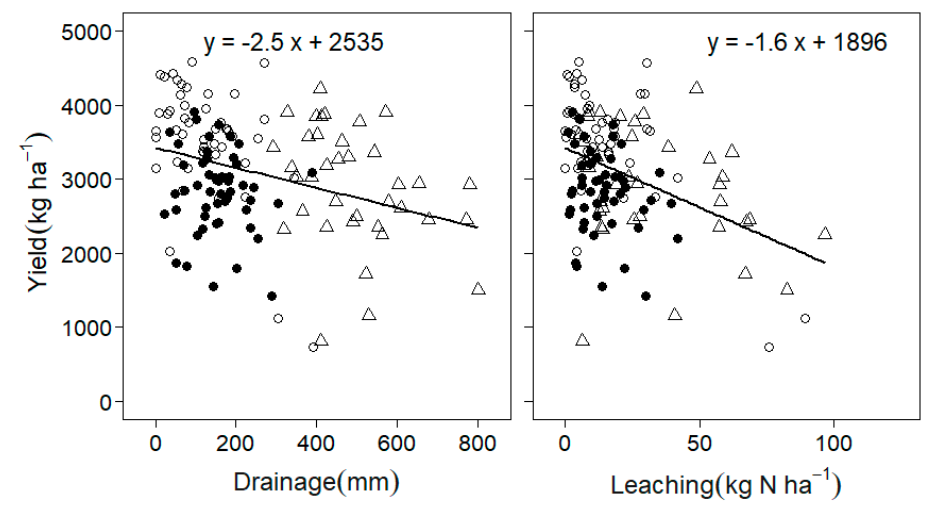
Figure 11. Simulated long-term NO 3 -N leaching and drainage against the yield of 75 kg N ha − 1 of AAMajor ( ○ ), AAMinor ( ● ), and WM ( △ ) for April, August, and May sowing windows respectively.